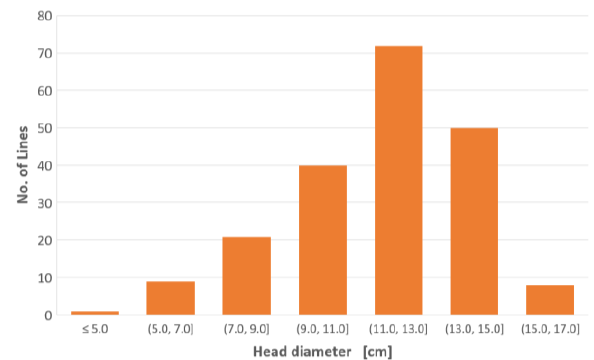
Figure 3: Diameter of cauliflower heads measured at 07-16-2016, N=222 Lines